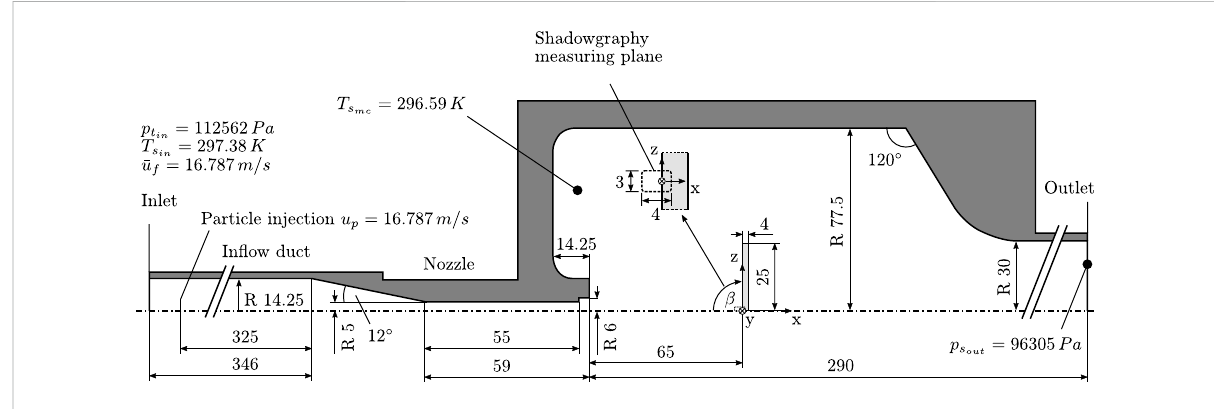
FIGURE 5 GeometryoftheEVScoresectionasmodeledintheCFDsimulationincludingthenozzle,measuringchamber,andtheboundaryconditionsfor the operation point OP1 (based on Hufnagel et al. (2018a) and Hufnagel et al.